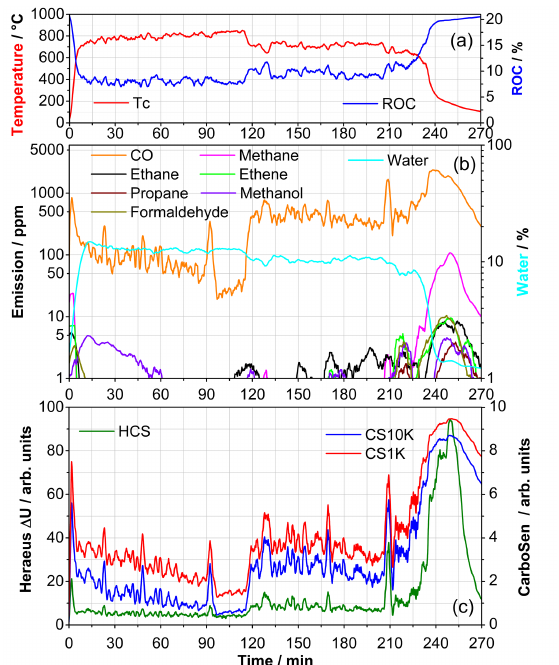
Figure 2. Typical sequence of (a) combustion temperature ( T c ) and residual oxygen concentration (ROC), (b) the continuous flue gas analysis (FTIR) and (c) the CO / HC sensor signals measured on the wood-chip-fuelled heater over time. The experiment started with cold ignition to steady-state operation at 70% nominal power (NP), a subsequent change to 50% NP at 120min and after about 225min the heater is operated down and stopped.